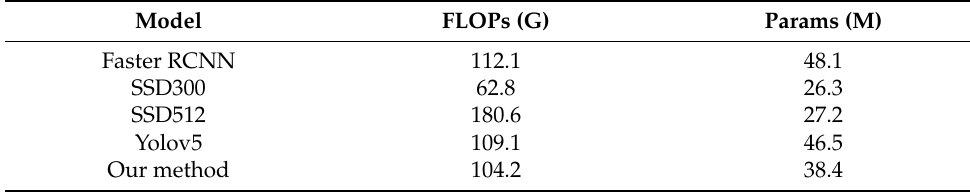
Table 3. Comparison with SOTA on computational cost.